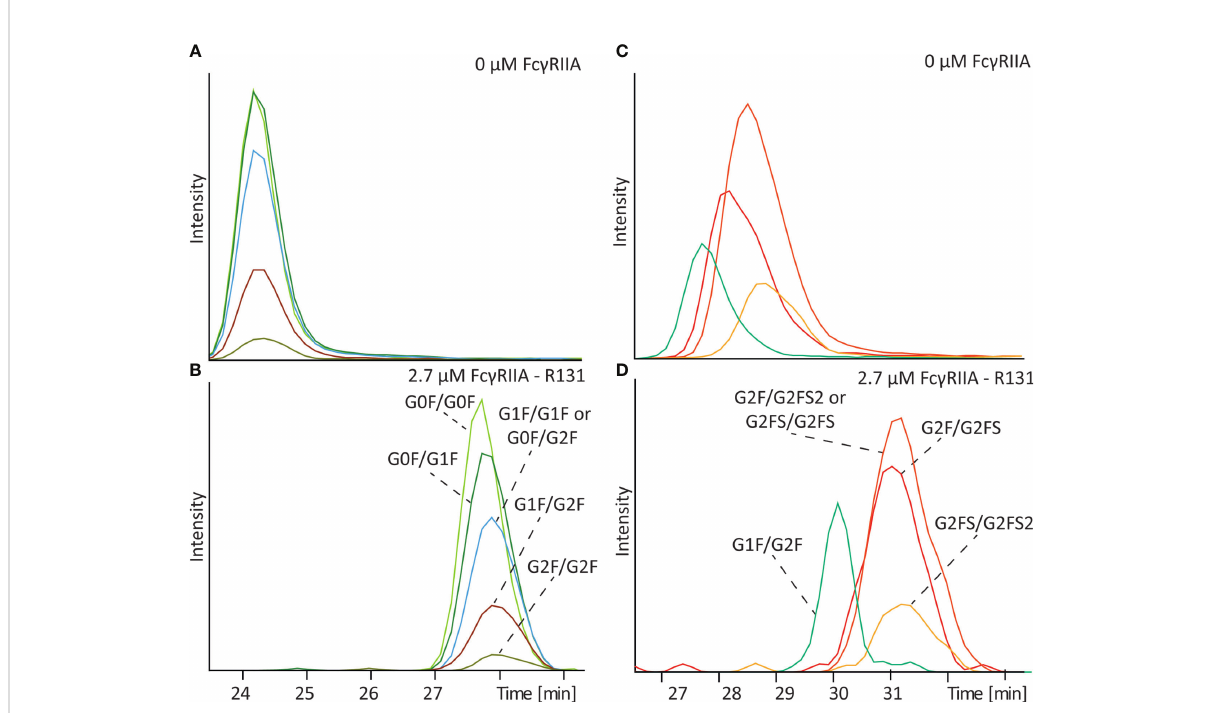
FIGURE 3 Af fi nity CE-MS analysis of mAb-C with (A) 0 µM Fc g RIIa or (B) with 2.7 µM Fc g RIIa and mAb-D (glycoengineered) mixed with mAb-D (wildtype) with (C) 0 µM Fc g RIIa or (D) with 2.7 µM Fc g RIIa. For clarity only G1F/G2F of the mAb-D (wildtype) is shown as an extracted ion electropherogram. For a complete overview of all glycan species in the sample please compare Figure